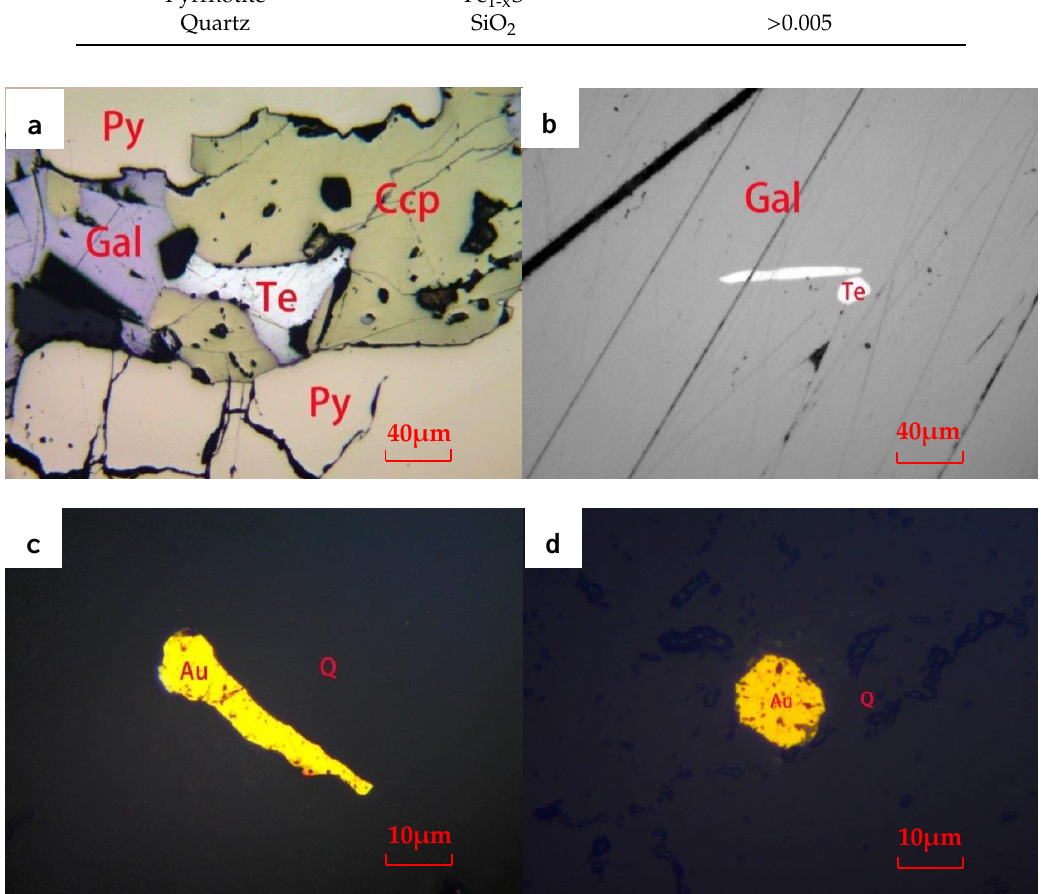
Figure 2. Ore association : ( a ) Long strips and round grains of fine-grained altaite and galena co-existing and interspersed with chalcopyrit; ( b ) long strips and round granular fine-grained altaite encased in galena; ( c ) a long strip of natural gold enclosed in late quartz; ( d ) circular grain of natural gold enclosed in late quartz.1cm (Py — pyrite; Gal — galena; Te — altaite; Ccp — chalcopyrite; Au — natural gold; Q — quartz).